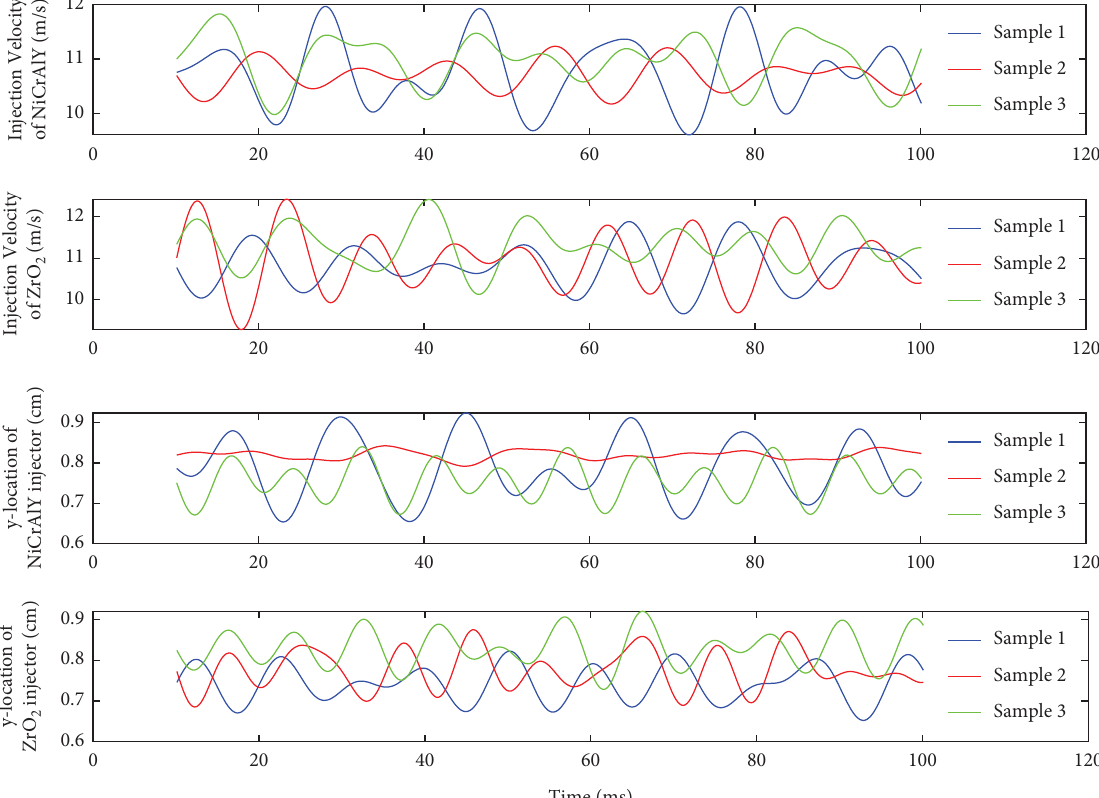
Figure 7: Variations of the injection velocities of the NiCrAlY and the ZrO for samples 1, 2, and 3 are listed in Tables 5 and 6.